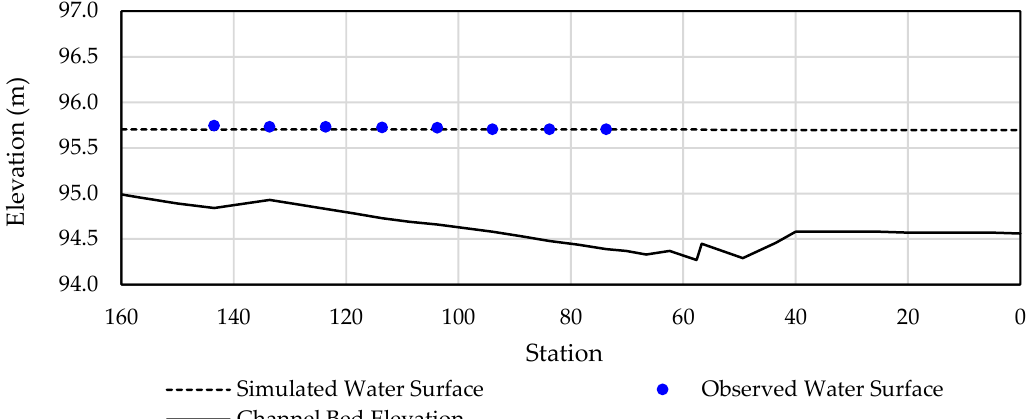
Figure 10. Comparison between the observed and simulated water surface with n = 0.025 to validate